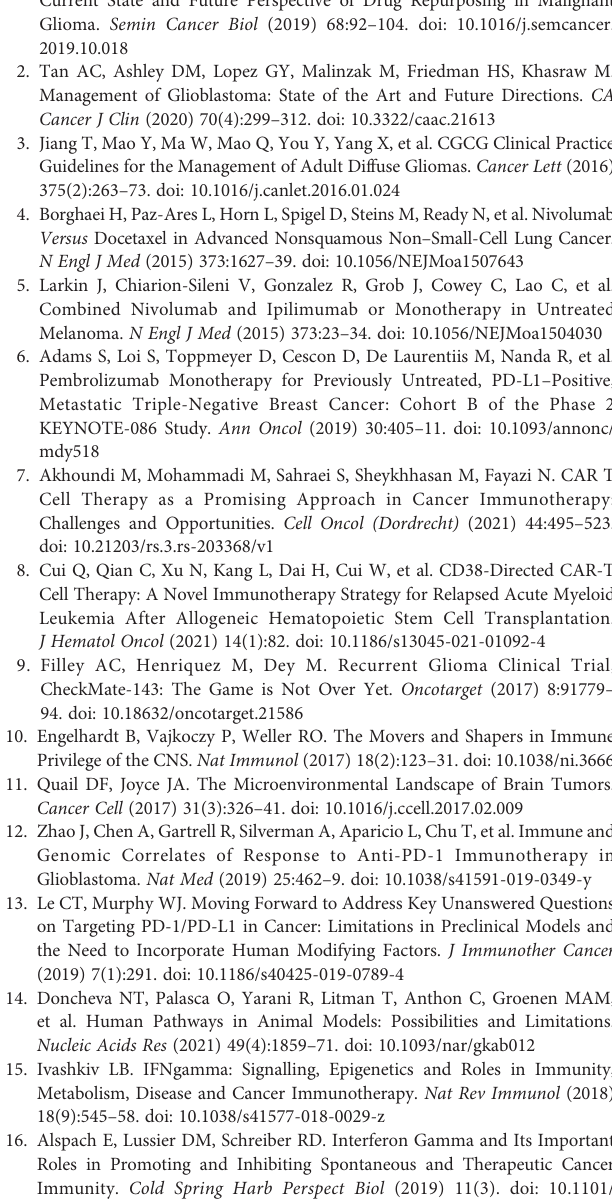
gene signature-based strati fi cation. These results indicated that the pan-cancer-based IFNG gene signatures were insensitive in predicting the prognosis of GBM. Supplementary File 1 | Gene sets associated with IFNG response, in fl ammation and innate immune responses, the adaptive immune response, previously establishedIFNGgenesignatures,aswellasM1/M2andmicrogliasignaturegenes. Supplementary File 2 | Chemokines recruiting T lymphocytes to the tumor niche. Supplementary File 3 | Multiple linear regression model for explaining the expression of immune